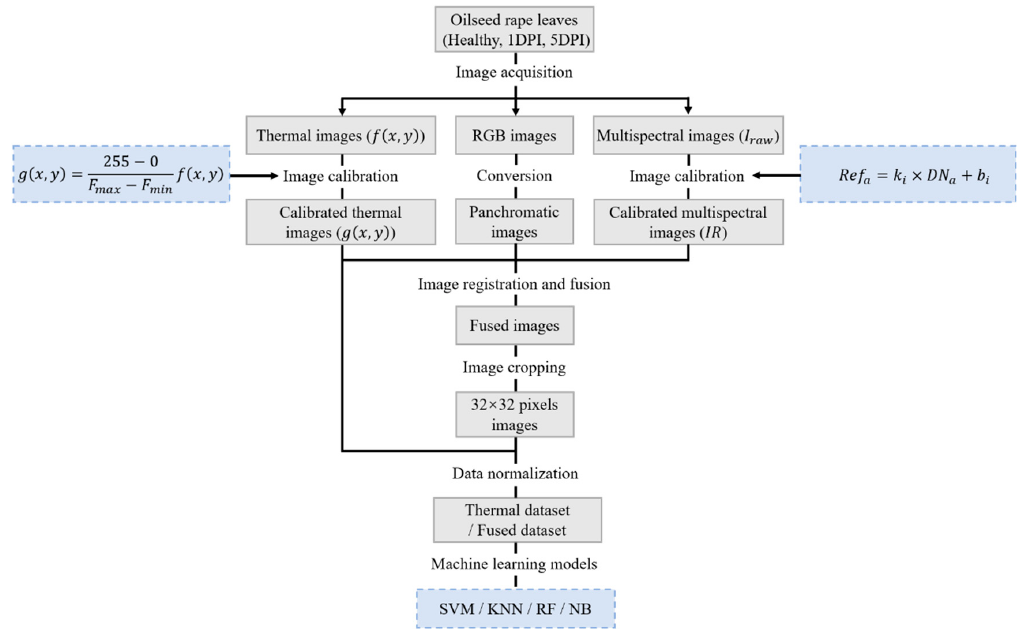
Figure 4. Flowchart of image acquisition and data analysis for detection of oilseed rape disease. Healthy, one day post infection (1DPI) and five days post infection (5DPI) oilseed rape leaves were the objects to be classified in this experiment.